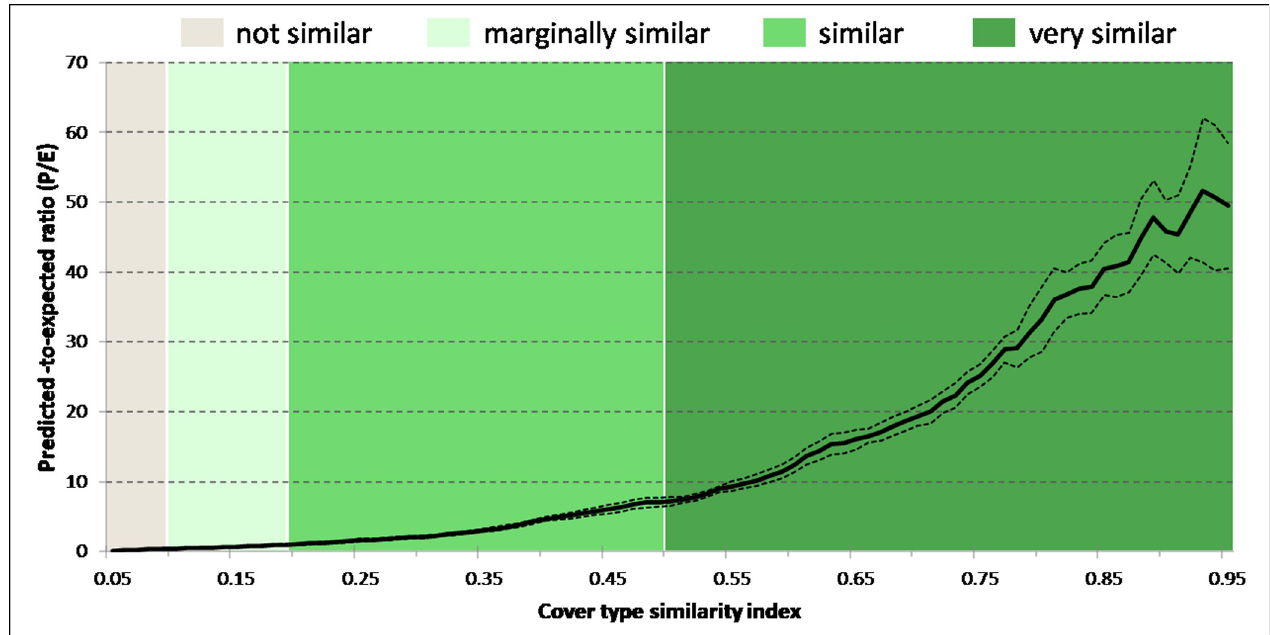
Fig 2. Predicted-to-expected (P/E) ratio curve. The P/E ratio curve [39] was used to evaluate, calibrate, and reclassify the forest vegetation cover type spectral similarity index model into four map classes. The solid black line is the mean P/E curve from bootstrapped replicates and dashed lines represent the 95% confidence